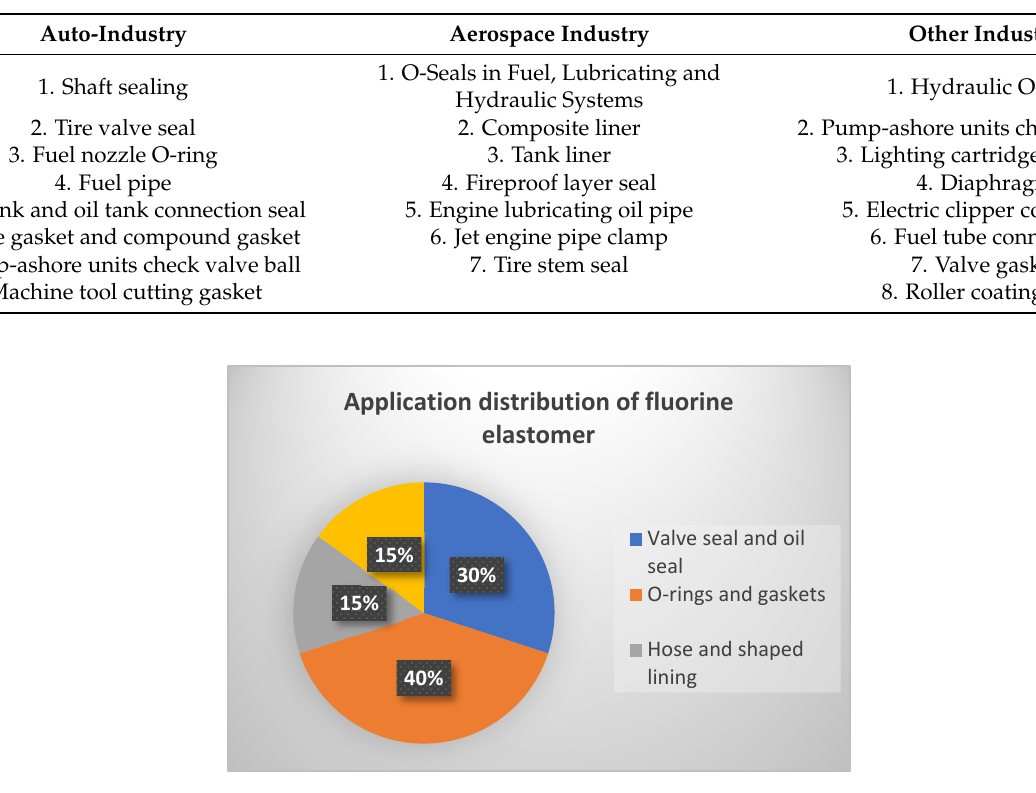
Figure 15. Distribution of applications of fluorine elastomers.